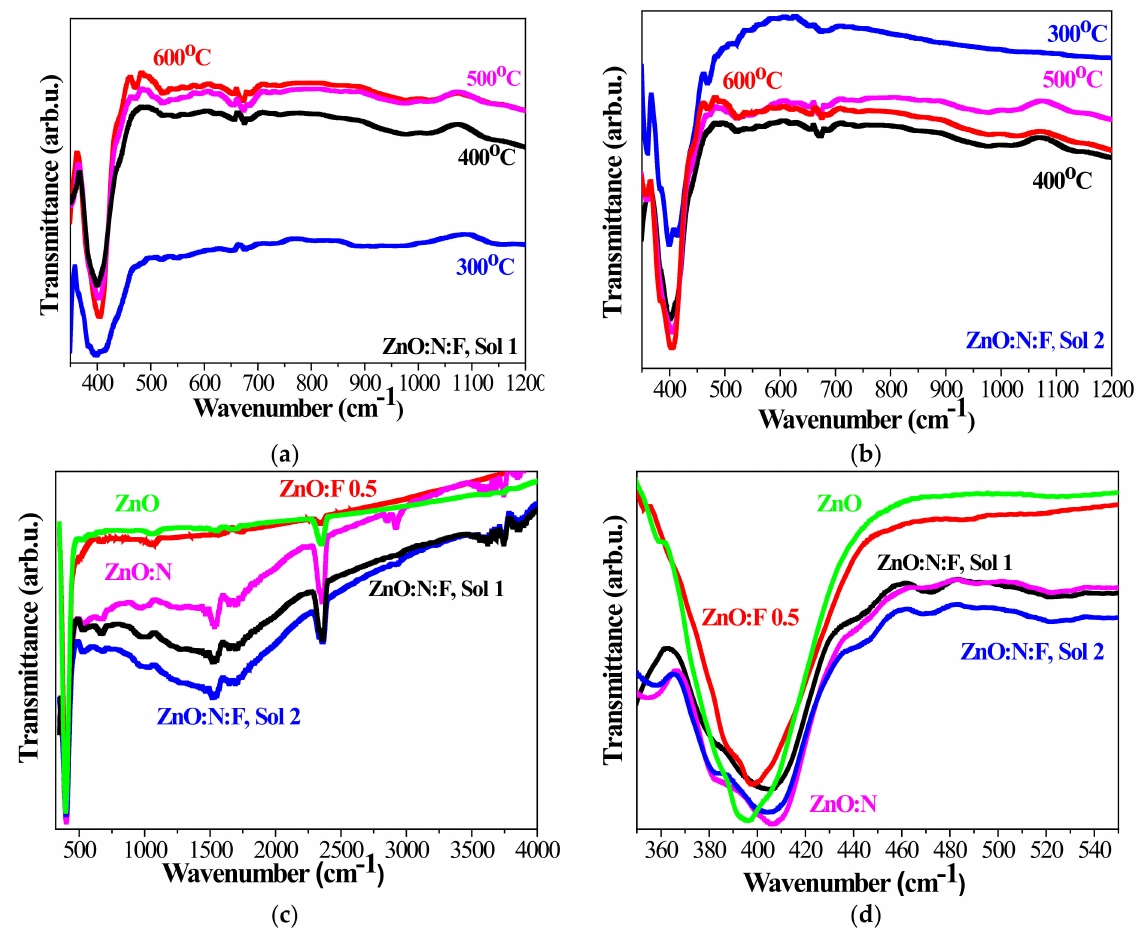
Figure 5. FTIR spectra of ZnO:N:F films, deposited from ( a ) Sol 1 and ( b ) Sol 2 and annealed at 300, 400, 500 and 600 ◦ C. Figure ( c ) presents the FTIR spectra of ZnO, ZnO:N, ZnO:F and ZnO:N:F films, treated at 600 ◦ C in the spectral range 350–4000 cm − 1 and ( d ) the enlarged spectra in 350–550 cm − 1